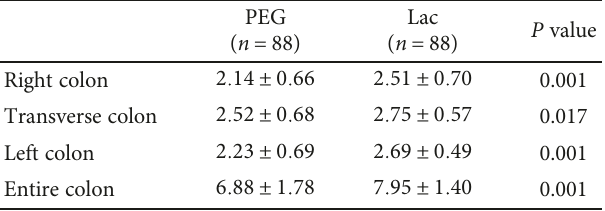
Table 4: E ffi cacy of bowel cleansing assessed with BBPS score.